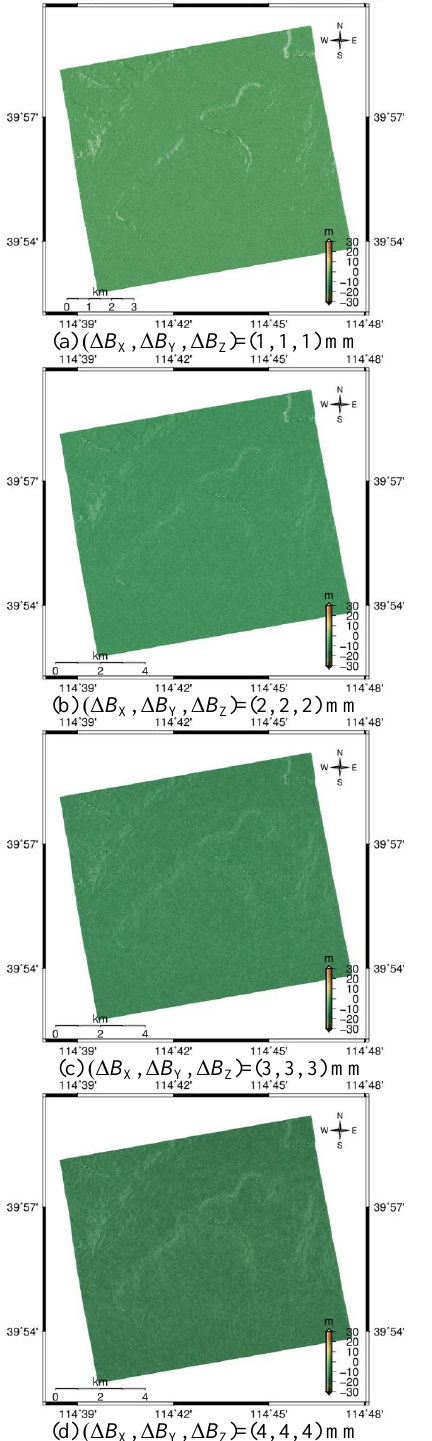
DEM, the height error distribution induced by the different baseline error was analysised and evaluated. Figure 7 shows the height error distribution graph corresponding to the different baseline error.